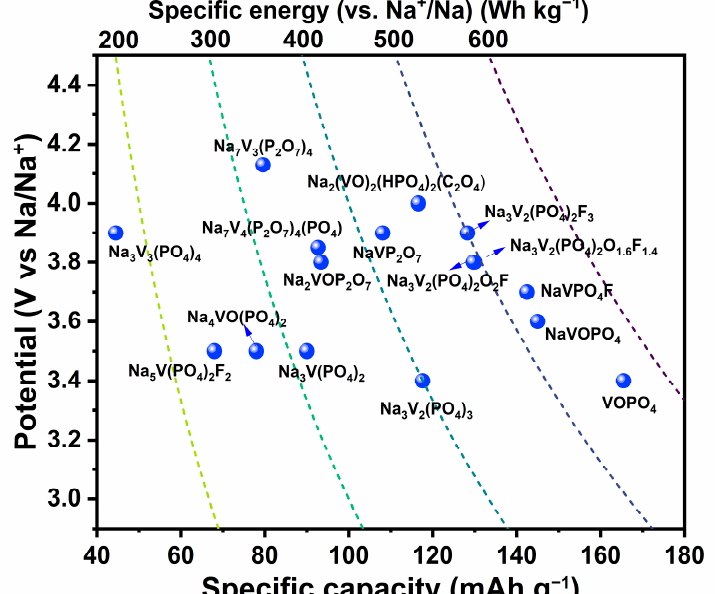
Figure 8. Comparisons among V-based polyanionic compounds for SIBs.